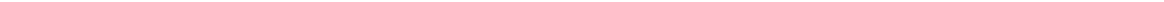
Fig. 7 Disruption of PI3K γ signaling in human or murine macrophages harms the killing of intracellular T . cruzi . a Representative fl ow cytometry dot plots for the analysis of CD11b staining and quanti fi cation of the absolute number of positive cells in the heart tissue of non-infected WT ( n = 5) and Pik3cg − / − ( n = 5) mice or 18 days post infection with 10 3 trypomastigote forms of T . cruzi Y strain. b Quantitative PCR analysis of nanogram of T . cruzi DNA presents in 1 ng of DNA from CD11b − and CD11b + cells isolated from the heart tissue of WT and Pik3cg − / − or Pik3cg KD/KD -infected mice. c Representative images of BMDMs stimulated with 0.1 or 1 ng of IFN- γ and infected for 48 h with trypomastigote forms of T . cruzi Y strain at MOI 3:1. Scale bars = 100 µ m. d Trypomastigote forms of T . cruzi Y strain released from culture of WT and Pik3cg − / − BMDM stimulated with 0.1 ng ml − of IFN- γ . Experiments were performed in triplicate. e Nitrite quanti fi cation by Griess reaction in the supernatant of WT and Pik3cg − / − BMDMs stimulated with 1 ng of IFN- γ and infected with T . cruzi Y strain at MOI 3:1. f Nitrate quanti fi cation in the heart tissue of WT ( n = 7) and Pik3cg − / − ( n = 7) naive mice or 18 days